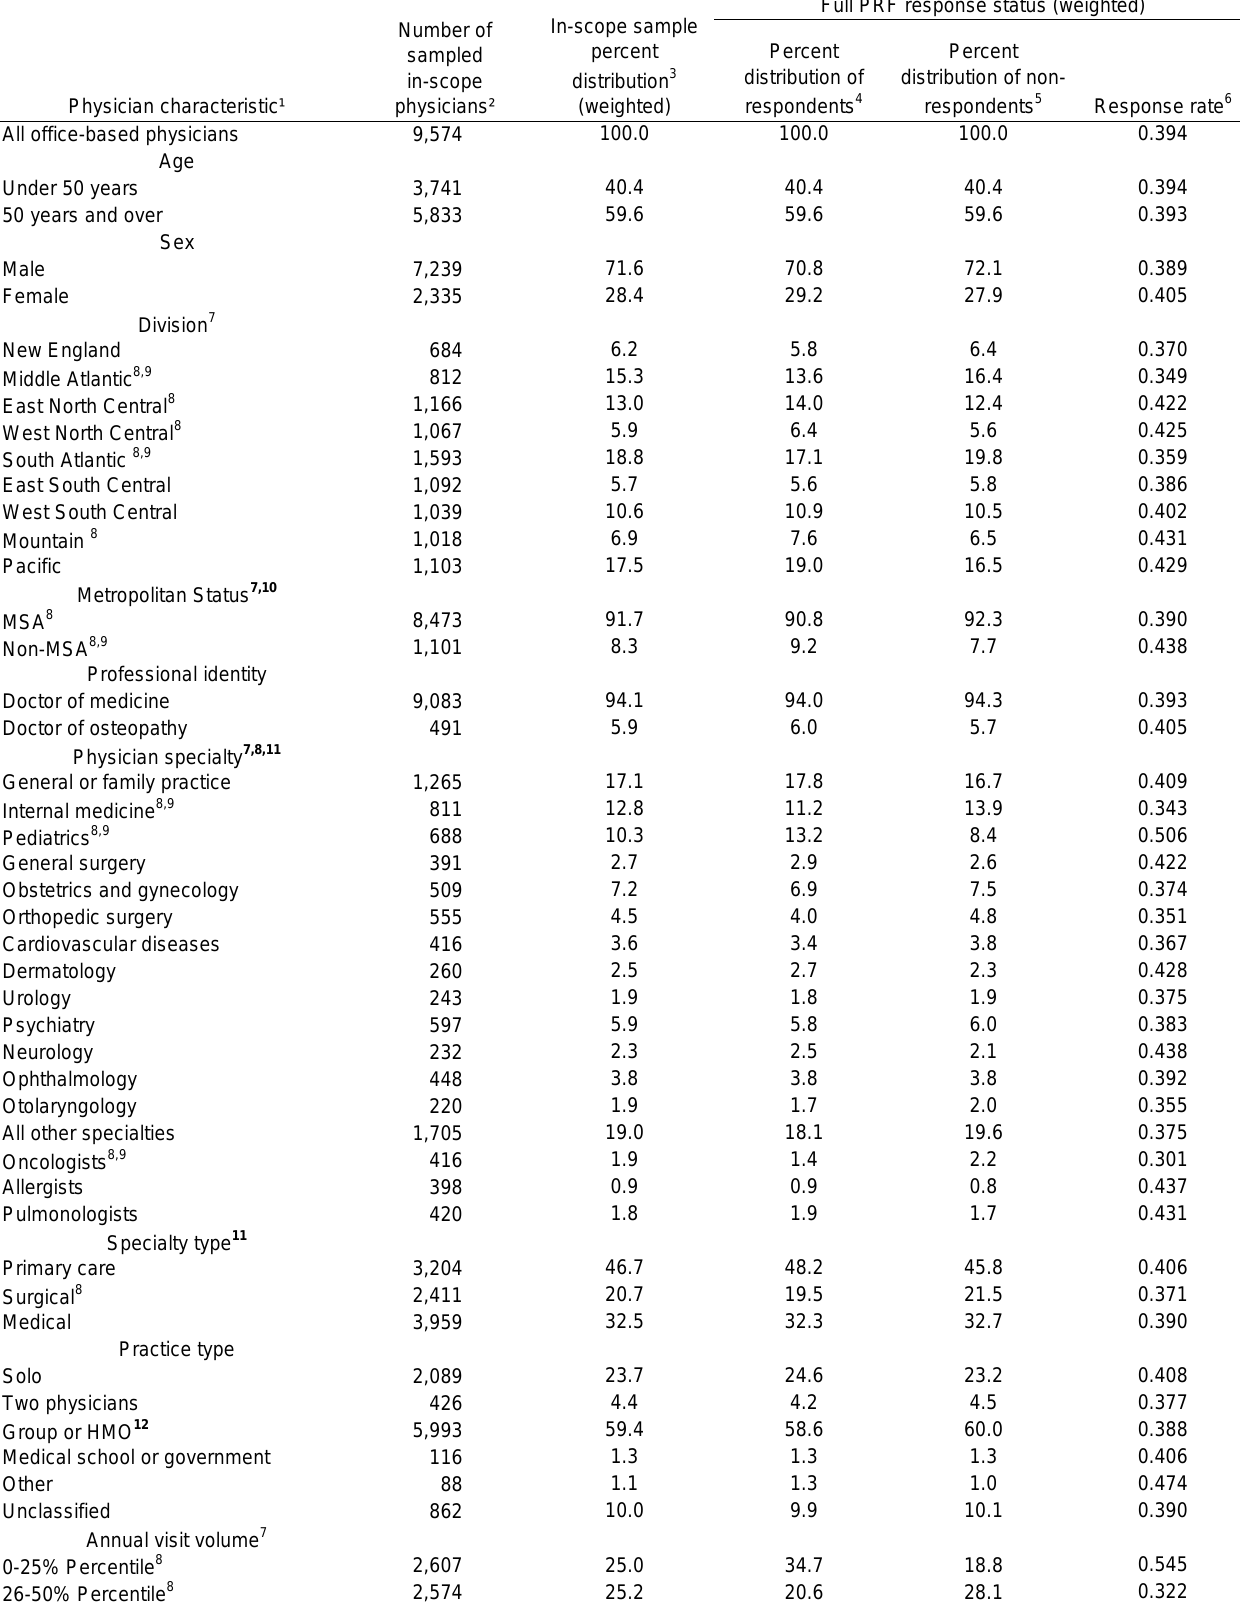
Table 31. In-scope sample physicians, their weighted percent distributions by Patient Record Form (PRF) response status, and PRF response rate, by physician characteristics: National Ambulatory Medical Care Survey, 2012 (Weighted by calibrated sampling